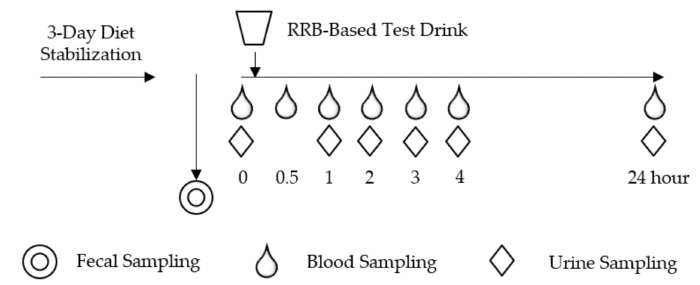
Figure 1. Postprandial study day schema.